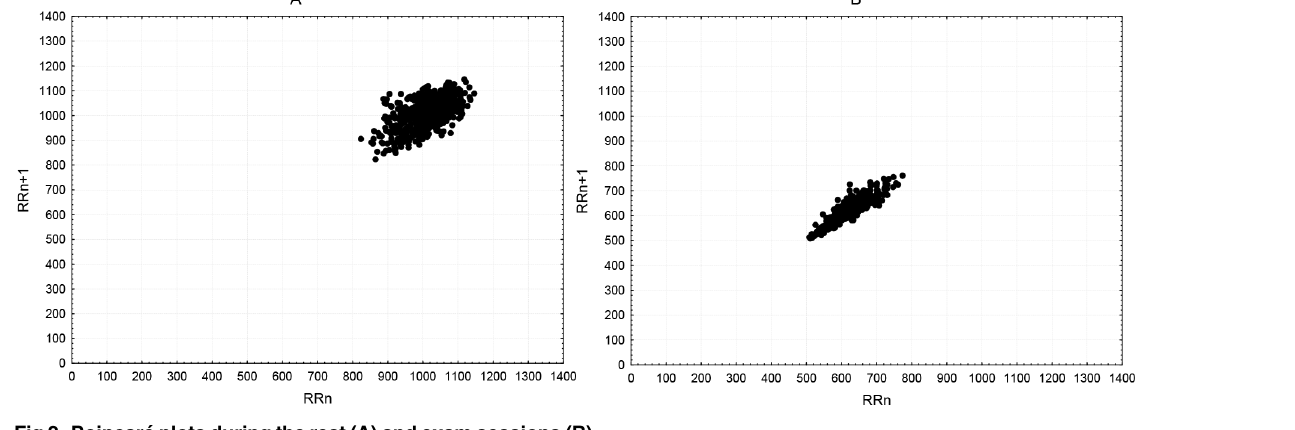
The Poincaré plot at rest displayed a greater dispersion of points than the exam session. Fig 2 shows a significant reduction in area from low SA (rest session) to high SA (exam session), with a contraction of length and a shortening of width in the plots. Compared with a student with low anxiety, the center of the ellipse from a participant with high anxiety is shifted down and to the left. Although the increase in SA induced a significant reduction in the width of the Poincaré plots (Table 1), the correlation between the changes in SD1 and SA did not reach sta- tistical significance (r = – 0.08, p > 0.05). Our results did not show a relationship between SD2 dynamics and fluctuations of state anxiety (r = 0.05, p > 0.05). No significant (p > 0.05)